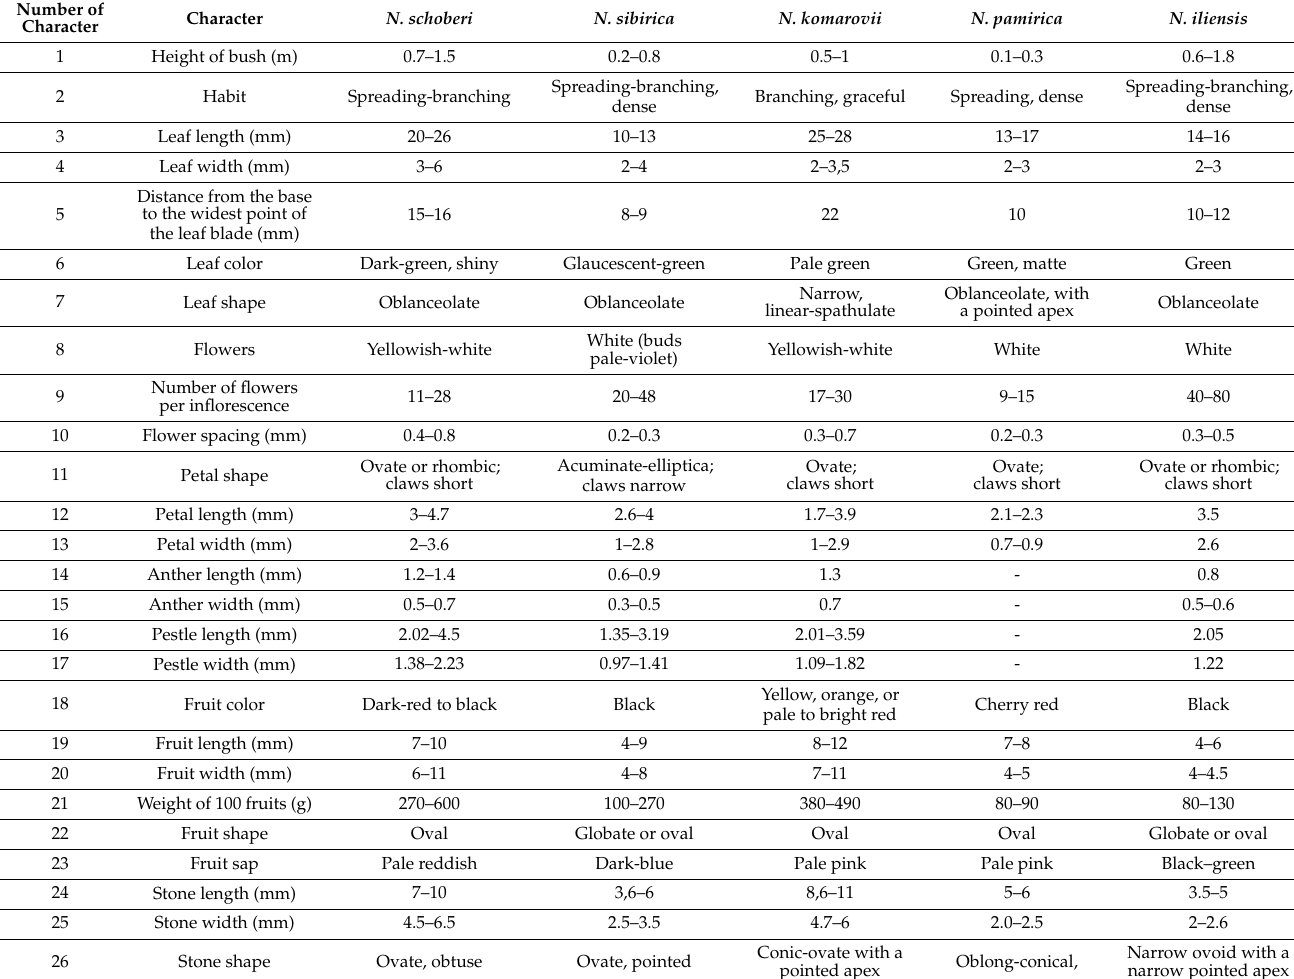
Table 1. Morphological characters of Nitraria species.